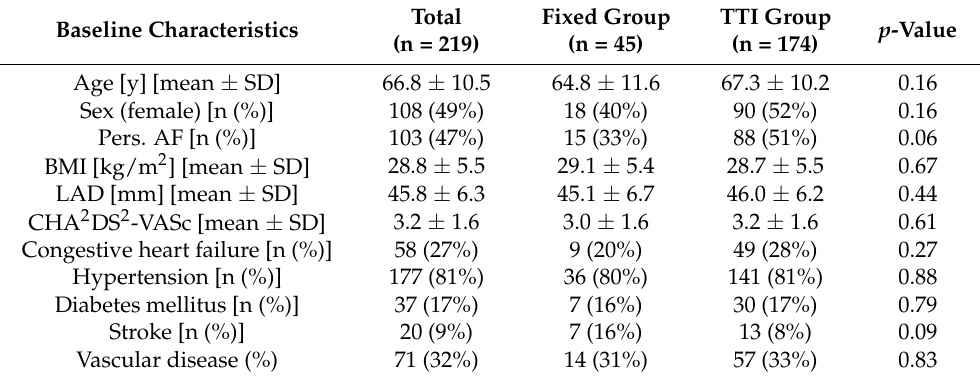
Table 1. Baseline